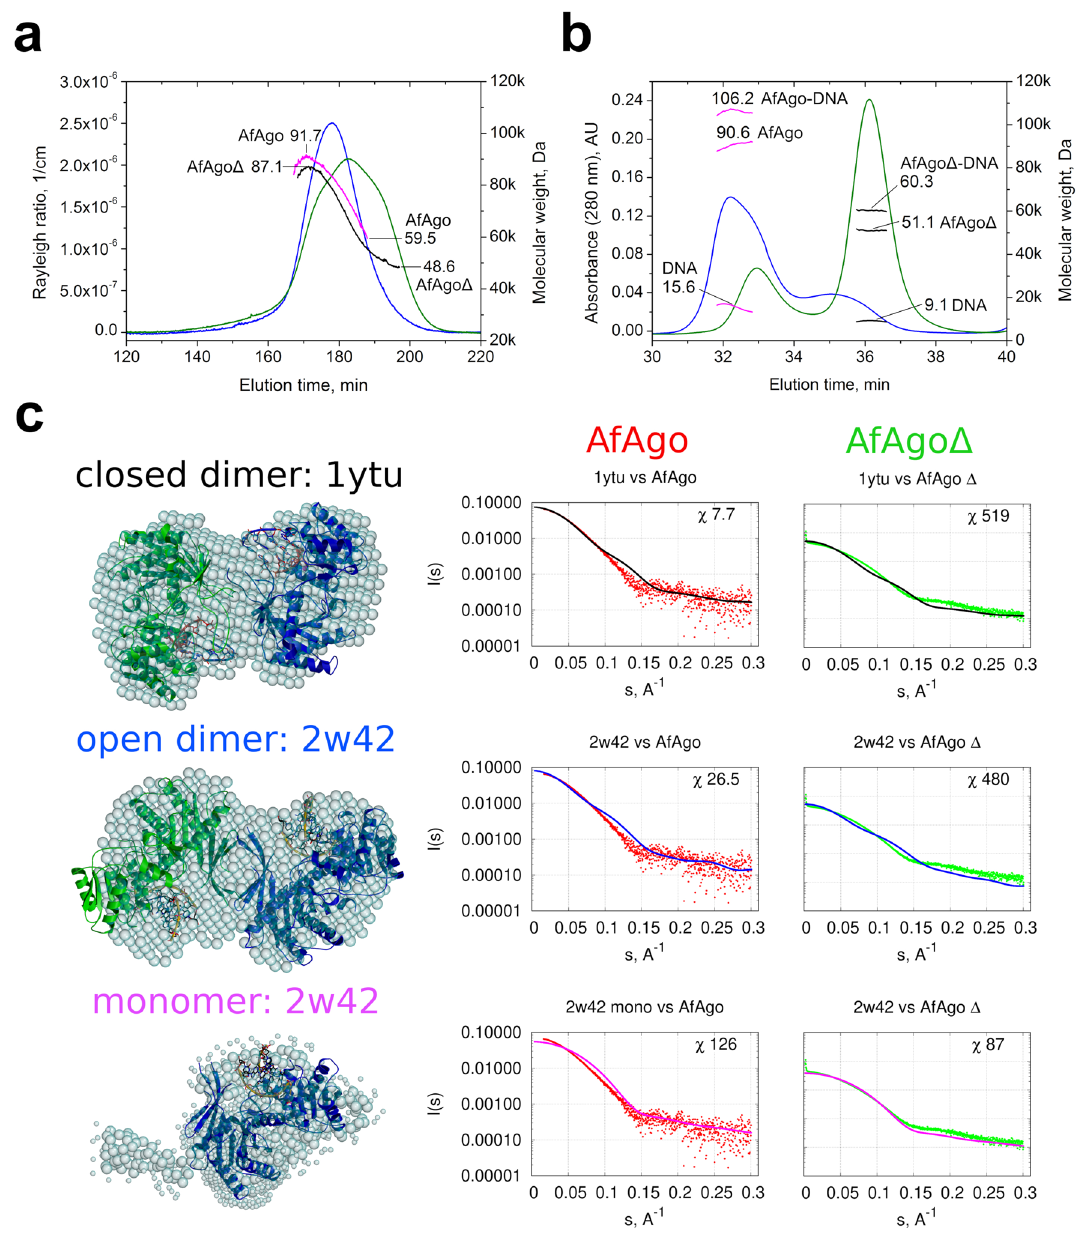
Figure 2. SEC-MALS and SAXS analysis of apo-AfAgo and AfAgo-DNA complexes. ( a ) SEC-MALS analysis of WT AfAgo and dimerization mutant AfAgoΔ unbound to nucleic acids. The light scattering data (blue for WT AfAgo, green for AfAgoΔ) is shown along with the calculated M w values (magenta for WT, black for mutant). The highest and lowest M w values calculated for each protein are indicated. Theoretical M w of WT AfAgo monomer is 50.8 kDa, theoretical M w of AfAgoΔ monomer is 49.9 kDa. ( b ) SEC-MALS analysis of AfAgo-DNA and AfAgoΔ-DNA complexes. The UV absorption data of AfAgo-DNA (blue) and AfAgoΔ-DNA (green) is shown along with the M w values of full complexes, the protein component, and the DNA component (magenta for AfAgo-DNA sample and black for AfAgoΔ-DNA sample, respectively). The theoretical M w of a 2:2 WT AfAgo:DNA complex is 119 kDa (2 × 50.8 + 2 × 8.7 kDa), theoretical M w of a 1:1 AfAgoΔ-DNA complex is 58.6 kDa (49.9 + 8.7 kDa). ( c ) SAXS data of WT AfAgo complex with MZ-1289 DNA (red points) and the dimerization mutant AfAgoΔ with MZ-1289 DNA (green points) are compared with the scattering curves generated from the “closed” dimer with dsRNA (PDB ID: 1ytu, black curves), “open” dimer (PDB ID: 2w42, blue curves) and AfAgo-DNA complex (PDB ID: 2w42, magenta curves) by CRYSOL. Corresponding AfAgo structures are shown in the second column superimposed with the dummy atom models generated using the SAXS data of the AfAgo complex with MZ-1289